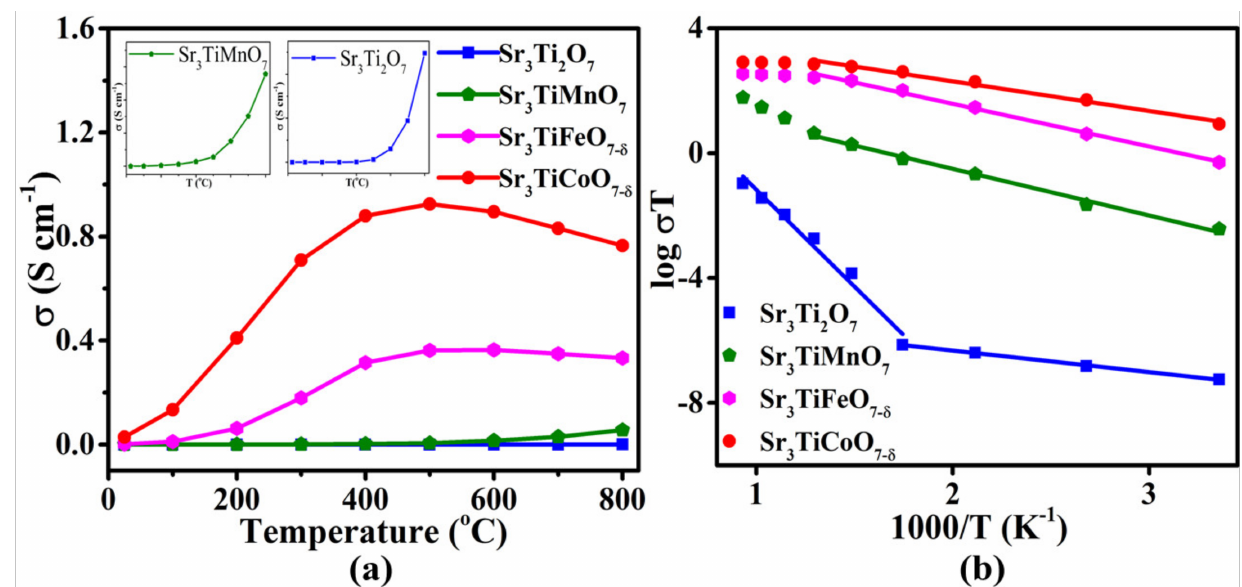
Figure 3. ( a ) Electrical conductivity variation as a function of temperature. The dotted box has been magnified in the inset to show the conductivity variations for Sr 3 Ti 2 O 7 and Sr 3 TiMnO 7 . ( b ) Arrhe- nius plots for determination of the activation energies (E a ) for the temperature-activated increase in conductivity.